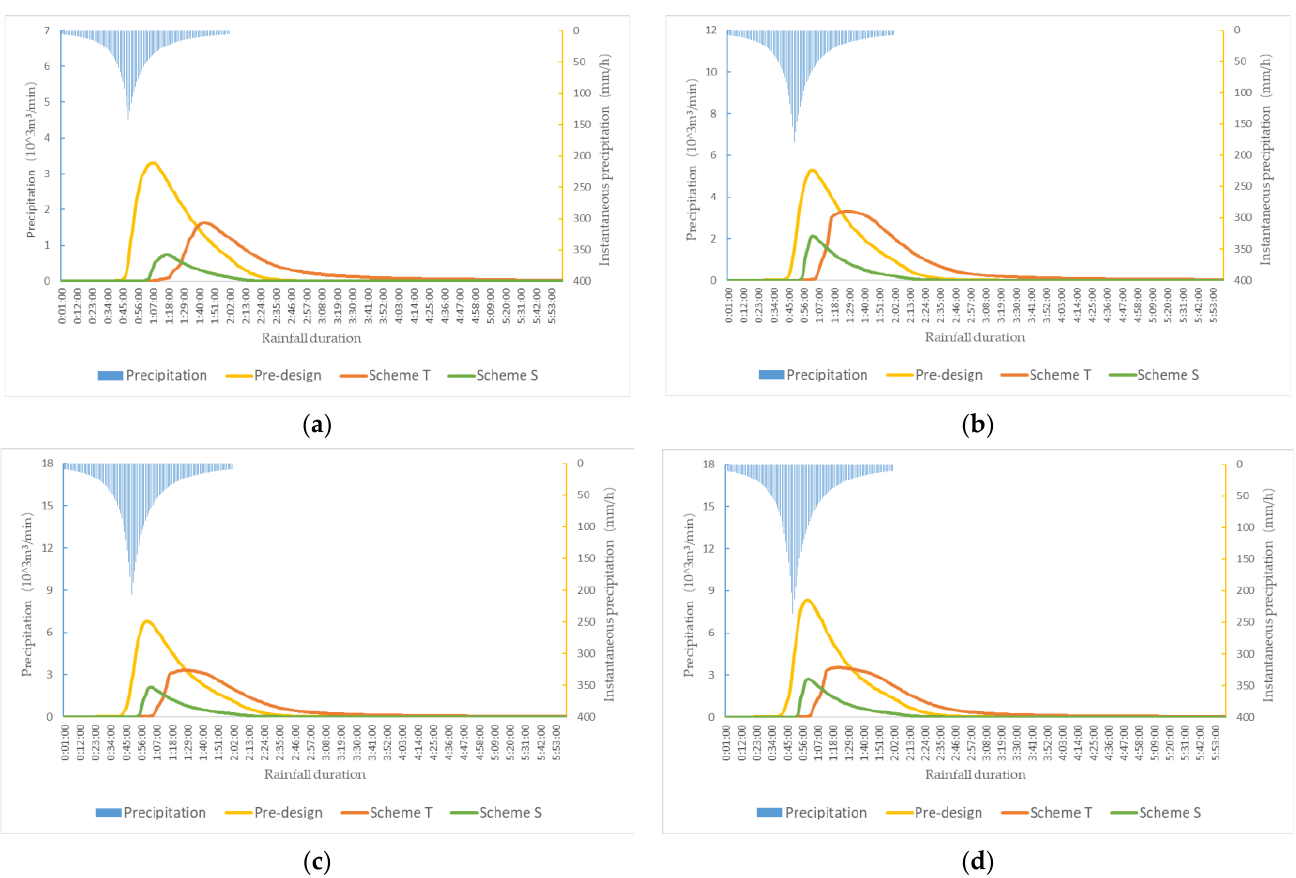
Figure 11. Time to the flood peak and outflow of in the event of a rainstorm with different return periods: ( a ) Total outflow from the outfall in a 2-year return period based on time; ( b ) Total outflow from the outfall in a 5-year return period based on time; ( c ) Total outflow from the outfall in a 10-year return period based on time; ( d ) Total outflow from the outfall in a 20-year return period based on time;.